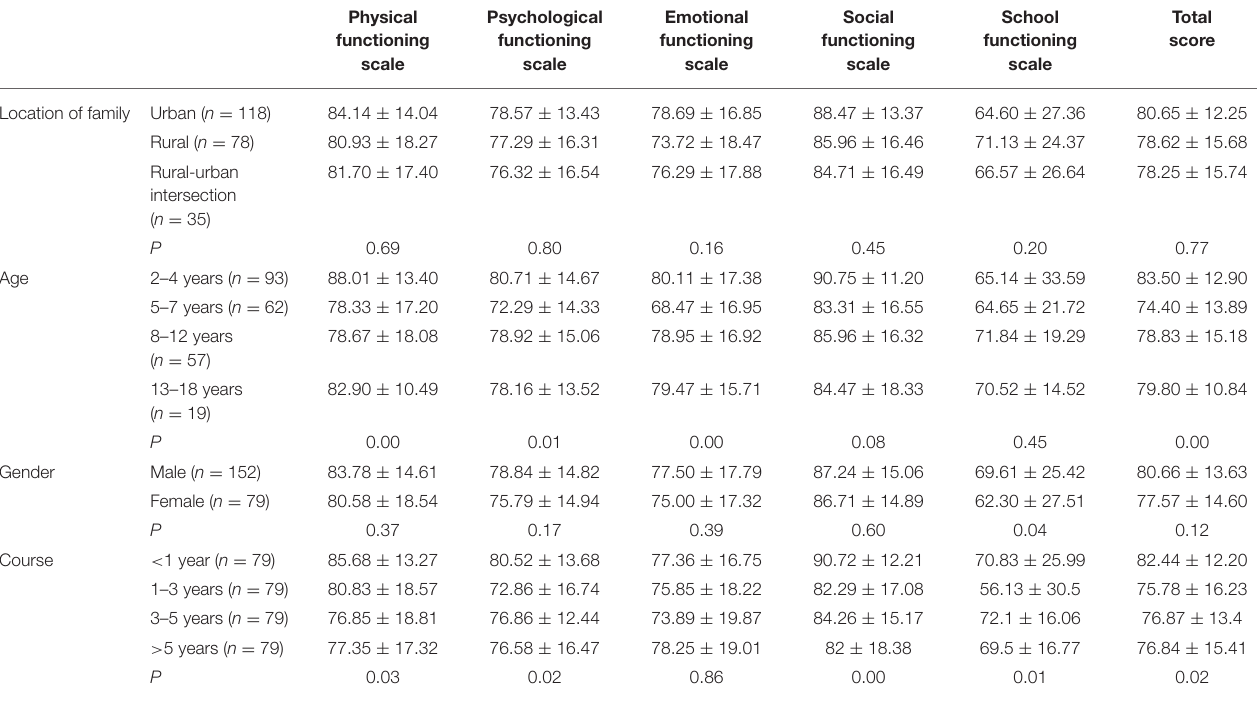
Physical Psychological functioning functioning scale scale